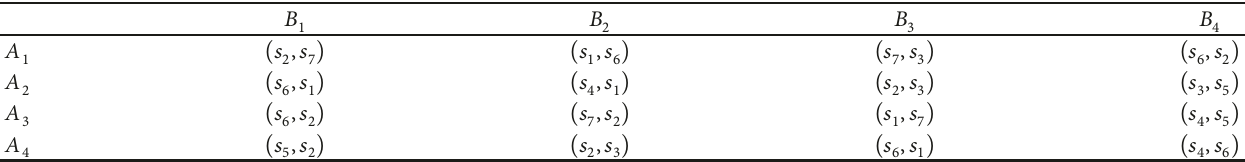
Table 3: The linguistic Pythagorean fuzzy preference information matrix 𝐿 3 provided by the decision-maker 𝑀 3 .